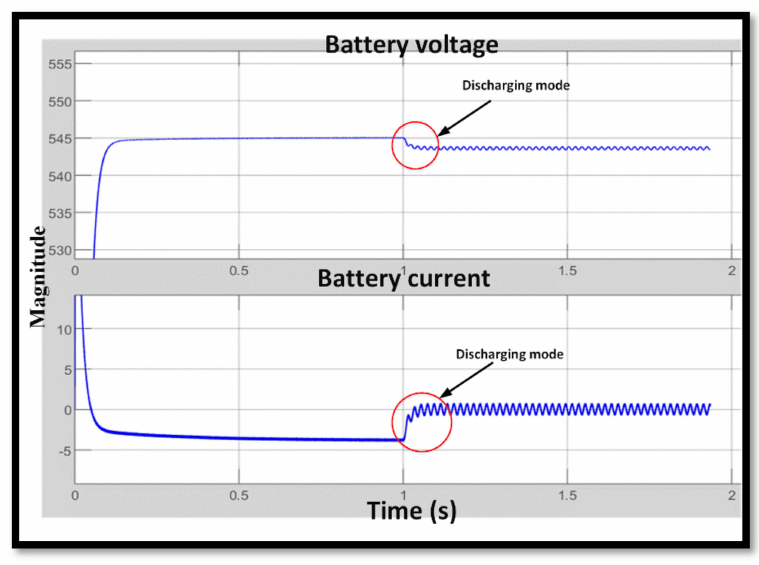
Figure 7. Battery